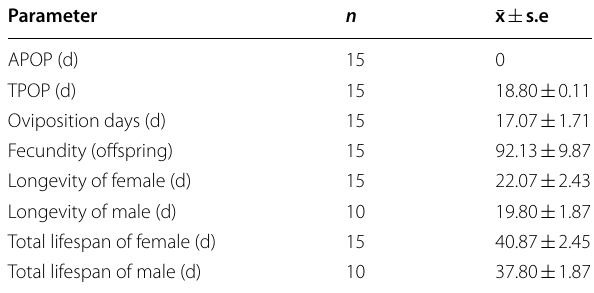
0.05) ≤ 0.05) ≤ Table 5 Adult preoviposition period (APOP), total preoviposition period (TPOP) (sum of developmental time and adult preoviposition period), and reproductive parameters